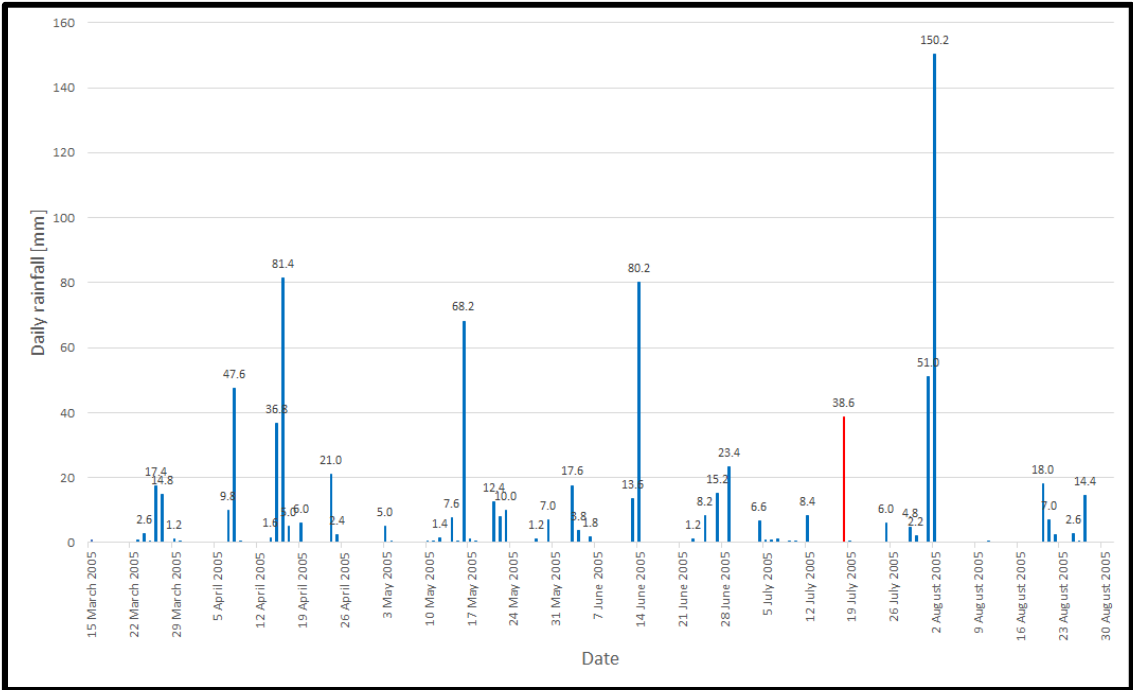
Figure 16. Hourly and accumulated rainfall recorded by Fomarco raingauge from spring wildfire to July 2005. Debris flow occurrence day in red.